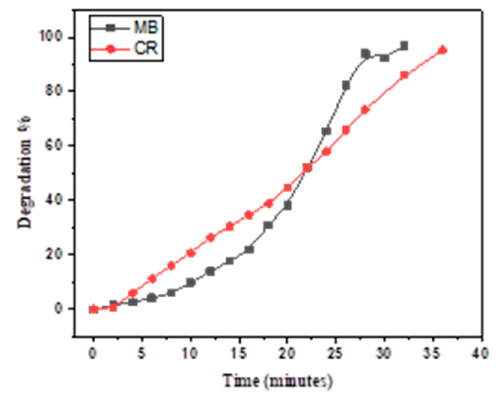
Figure 13. Consolidated graph showing the comparative degradation of two dyes using CA-AgNPs.